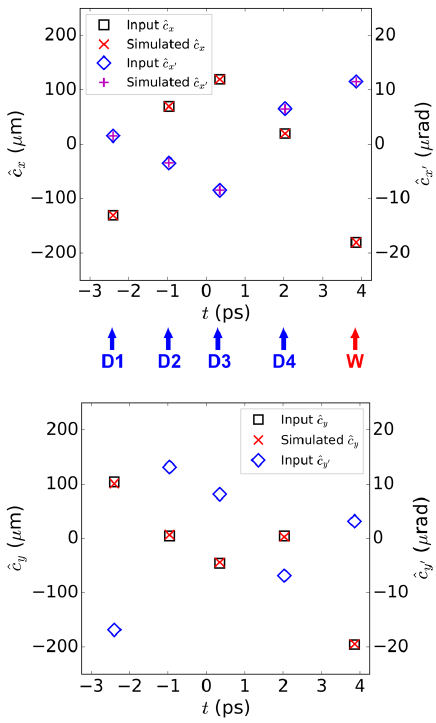
FIG. 3. Comparisons between the input and simulated mis- alignments in both planes without any jitter. The bunch train head is on the left. The inputs ˆ c are also shown in the plot since they y 0 affect the accuracies of ˆ c . y